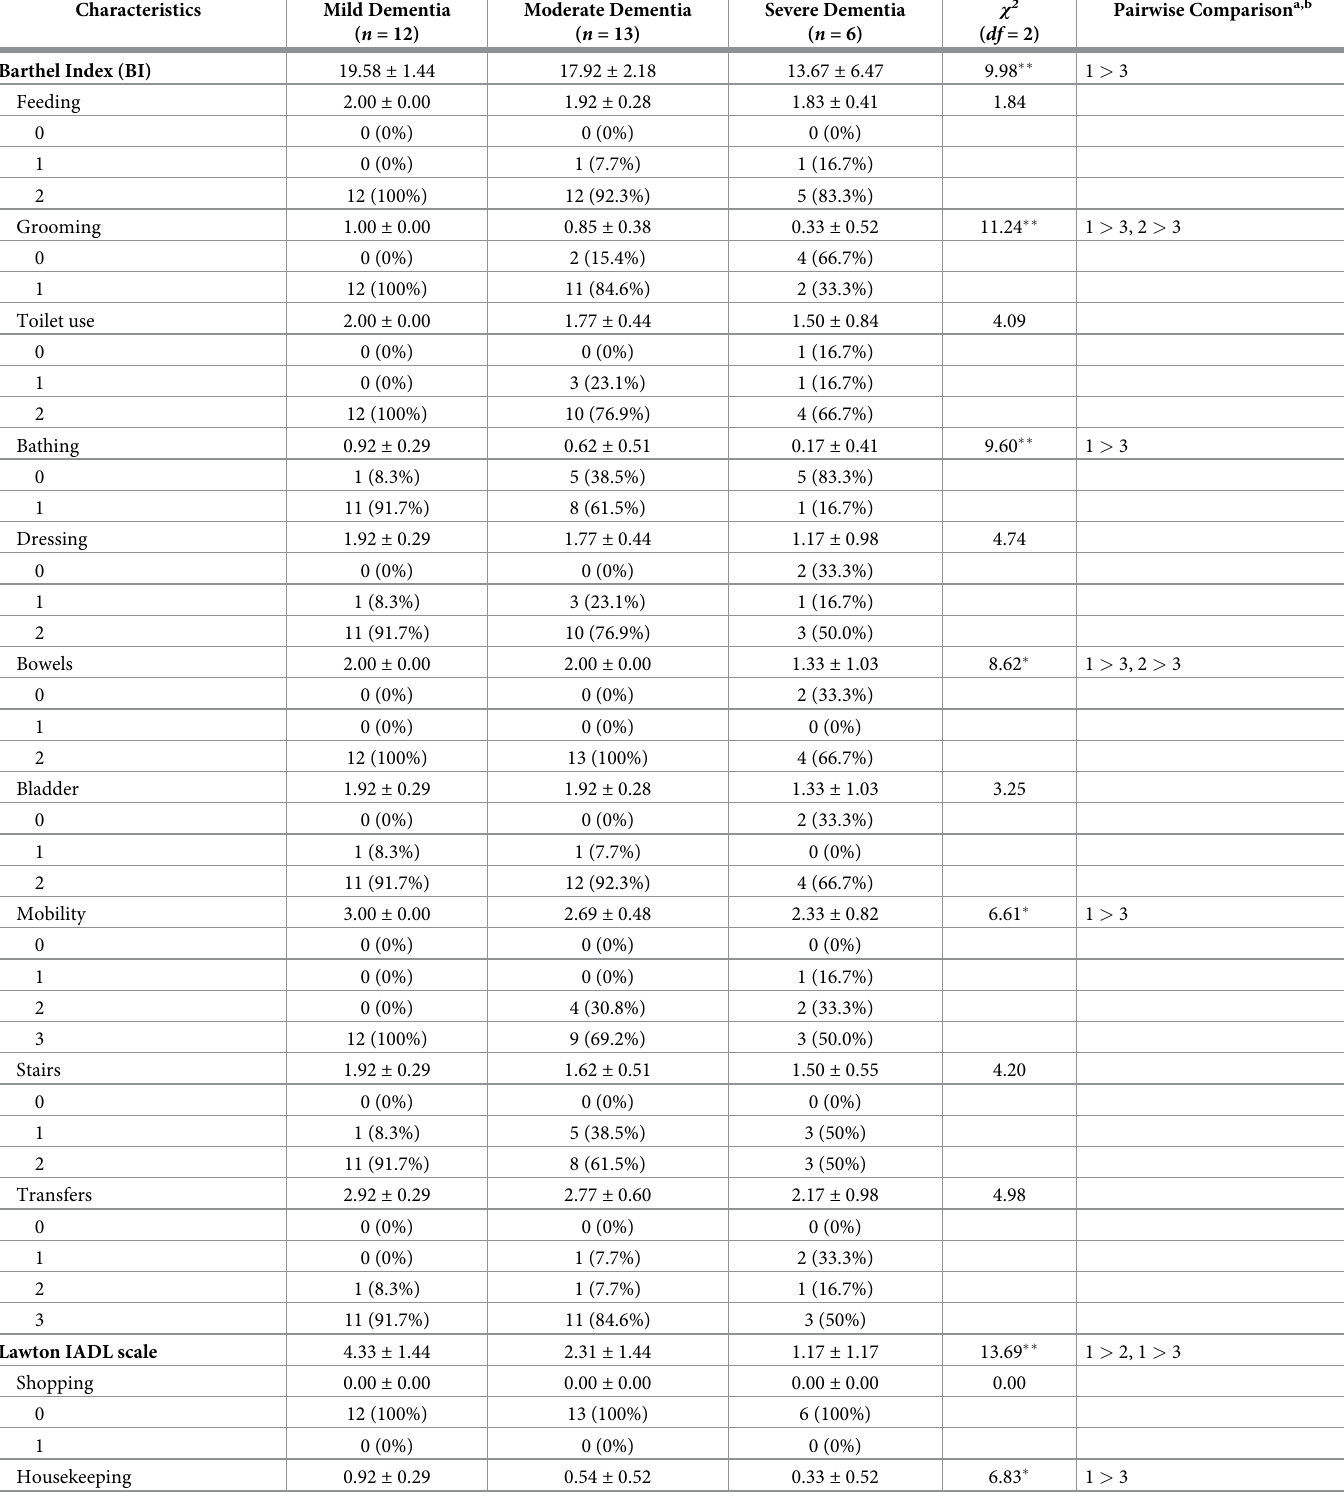
Table 4. Univariate analysis of the basic and instrumental activities of daily living functions among the subjects with mild, moderate, and severe dementia respectively.